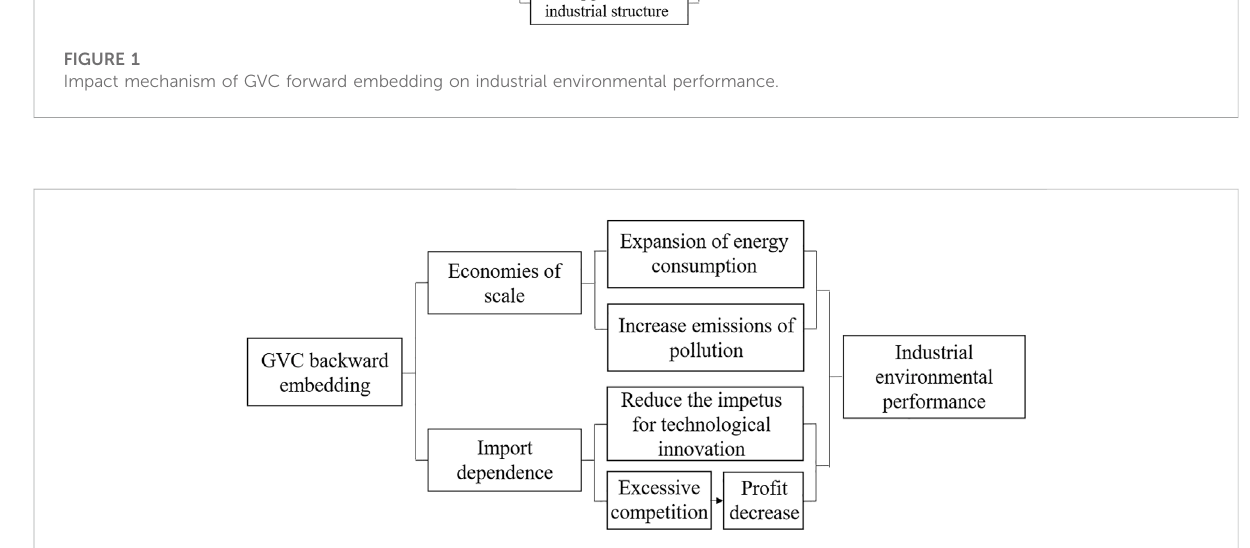
FIGURE 2 Impact mechanism of GVC backward embedding on industrial environmental